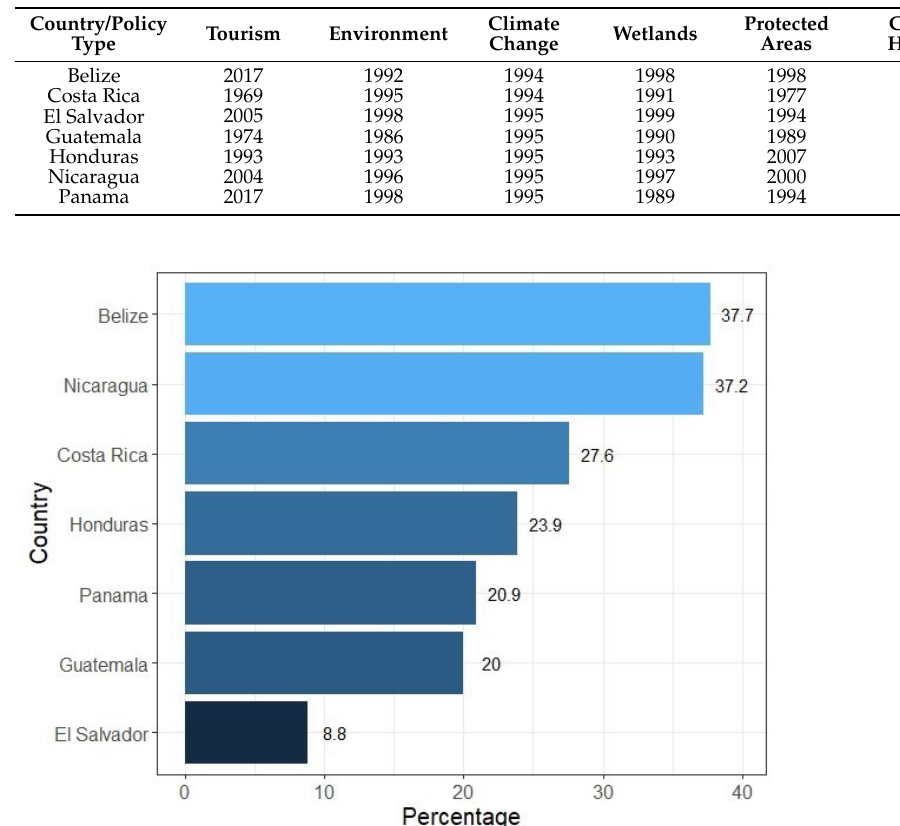
Figure 8. Terrestrial protected areas by country (percentage of total land area in 2018).